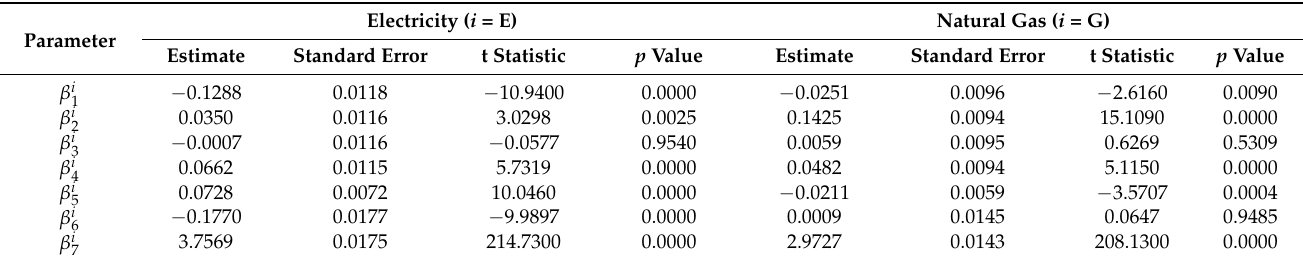
Figure 3. Spanish daily electricity and natural gas prices from 2016 to 2019. Table 2. Daily deterministic